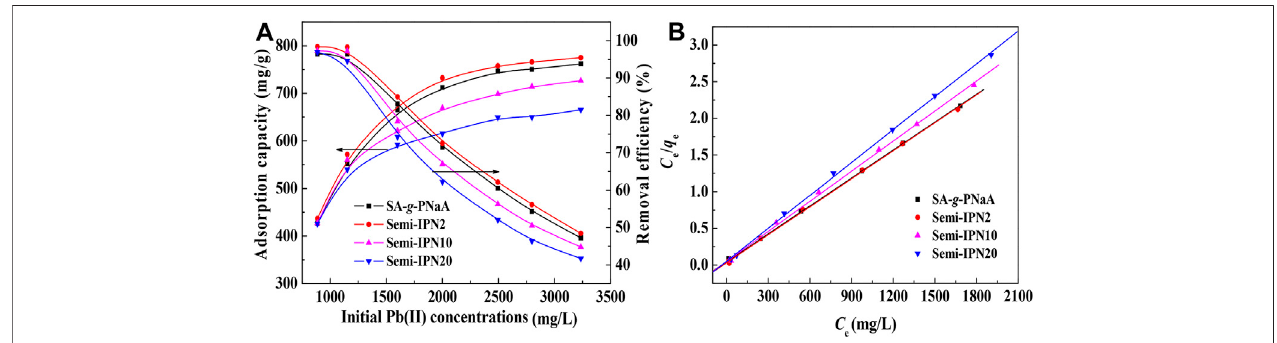
FIGURE 5 | (A) Variations of adsorption capacity and removal ef fi ciency of the adsorbent for Pb(II) as a function of initial concentration; (B) Plots of C e / q e vs. C e obtained by fi tting with Langmuir isotherm model. Adsorption conditions: pH, 5.0; adsorbent dosage, 2 g/L; adsorption time, 120 min; adsorption temperature, 30 ° C.